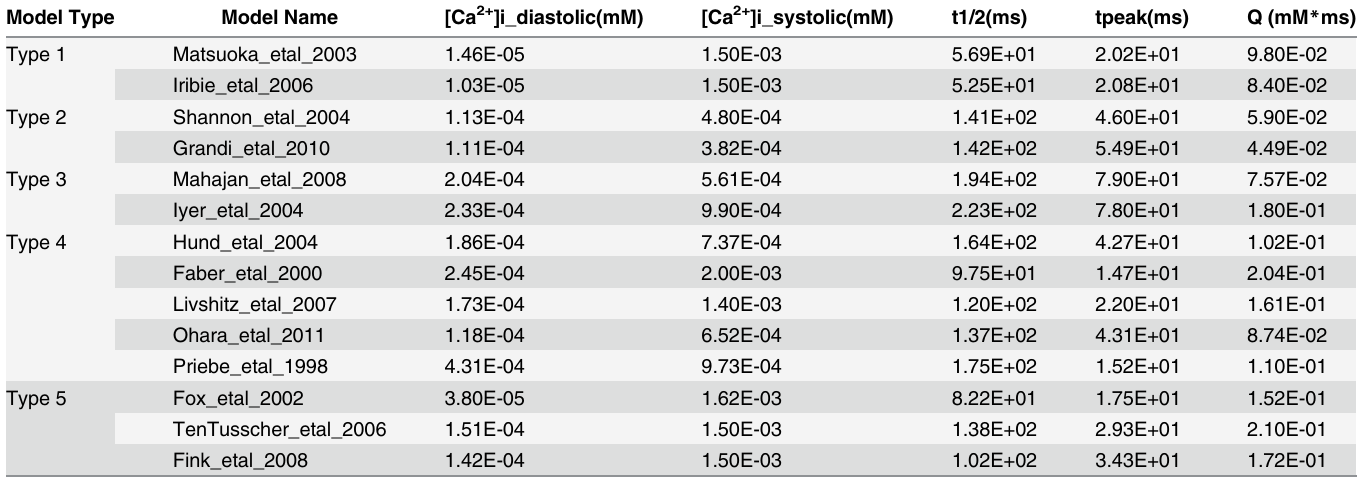
Table 5. Data for steady priming beat: EP models without